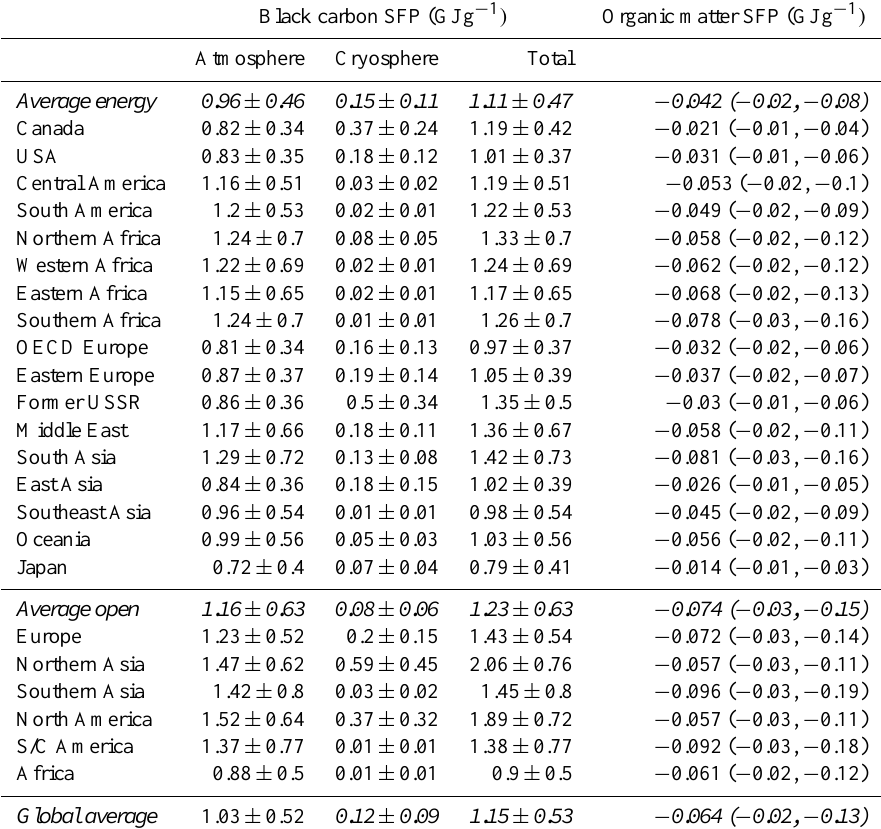
Table 1. Ensemble-adjusted Specific Forcing Pulse (SFP) for black carbon and organic matter. Uncertainties for OM are asymmetric and are presented as